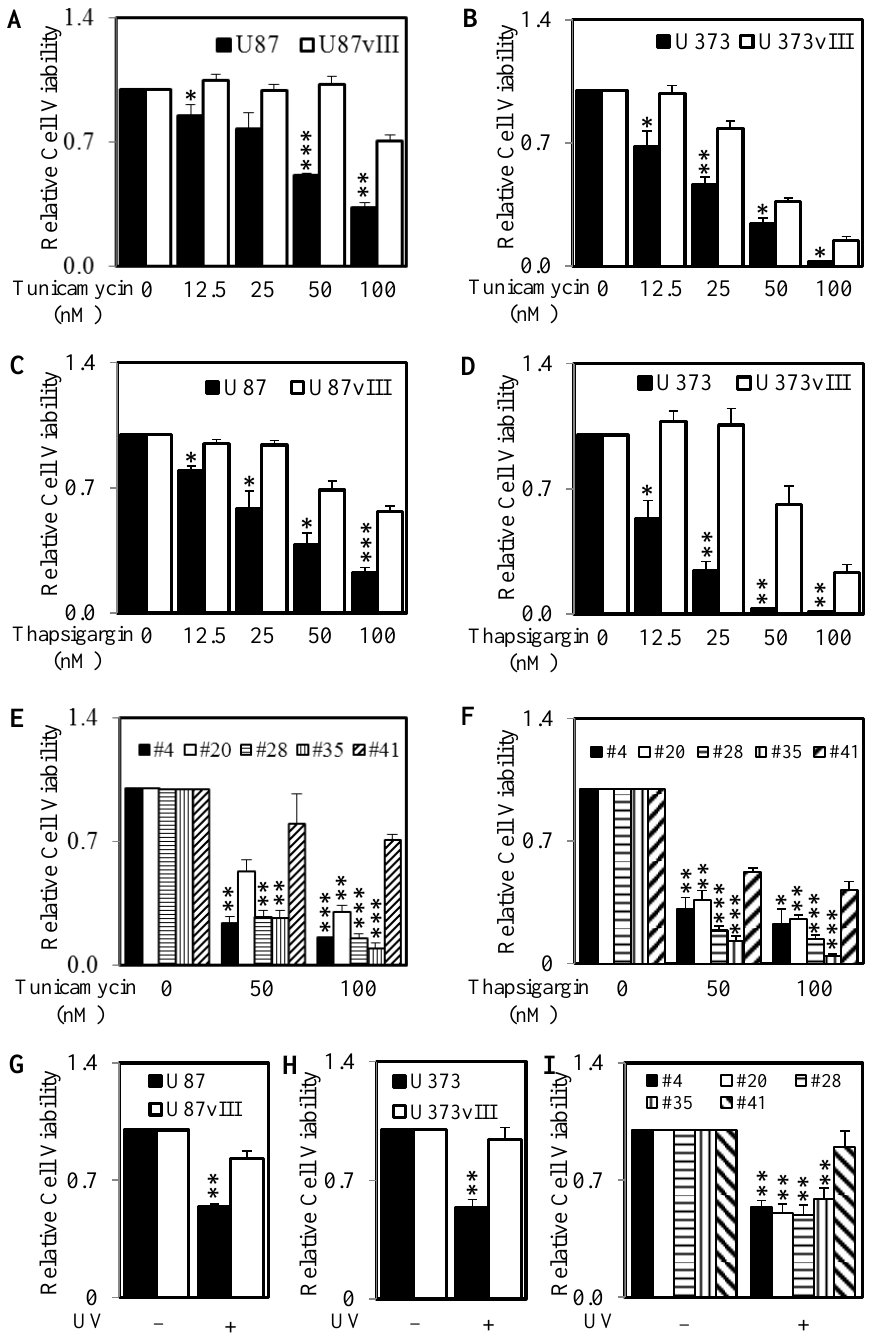
Figure 3. EGFRvIII expression correlates with increased survival after exposure to tunicamycin, thapsigargin and UV light. ( A – D ) U87, U87vIII, U373 and U373vIII cells were treated with increasing doses of tunicamycin ( A , B ) or thapsigargin ( C , D ) for 72 h. Cell viability was then determined using a commercially available Cell Titer-Glo kit and samples read on a bioluminometer. Data are expressed as % viability compared to untreated cells ± S.D of at least 3 independent experiments, each with 3 experimental replicates. #4, #20, #28, #35 and #41 glioblastoma cells were treated with increasing doses of ( E ) tunicamycin or ( F ) thapsigargin for 72 h. Cell viability was then determined as described above. ( G ) U87, U87vIII, ( H ) U373, U373vIII and ( I ) #4, #20, #28, #35 and #41 glioblastoma cells were exposed to UV light for 10 min and cell viability was examined following another 72 h as determined above. * p < 0.05; ** p < 0.01; *** p <